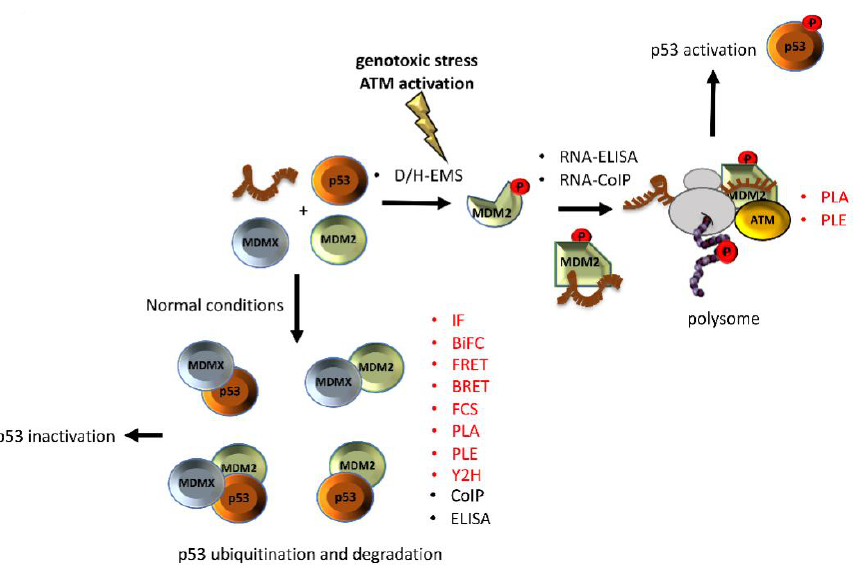
Figure 2. Different techniques have been used to unravel the interaction among of p53-MDM2-MDMX. A phosphorylation on Ser 395 of the MDM2 change its conformation and allow the binding of the p53 mRNA that results in increased p53 protein synthesis after DNA damage. On the other hand, under normal conditions, interaction of MDMX and/or MDM2 with p53 negatively controls the p53 levels. Techniques that allow us to study the interactions in-situ are shown in red.